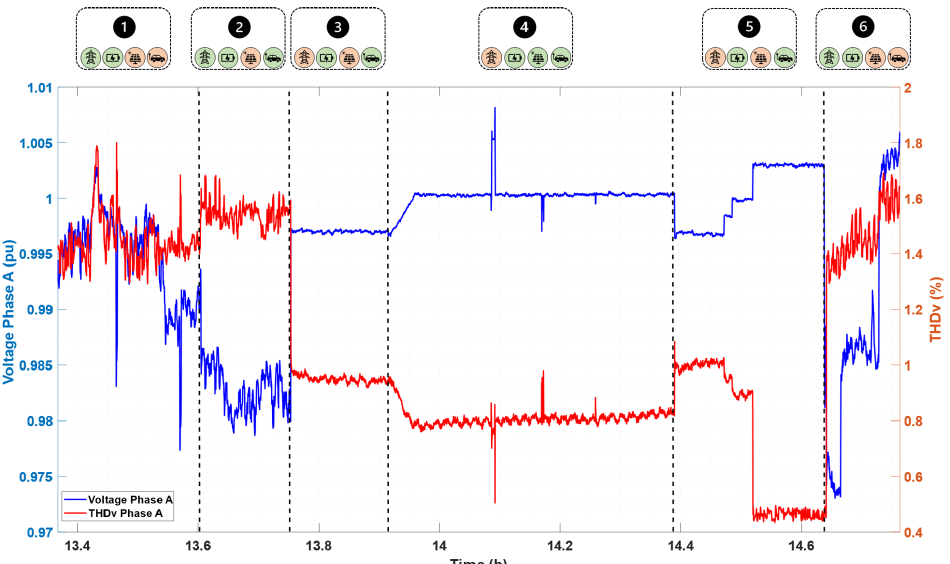
Figure 7. Voltage and voltage harmonic distortion of the system collected by power